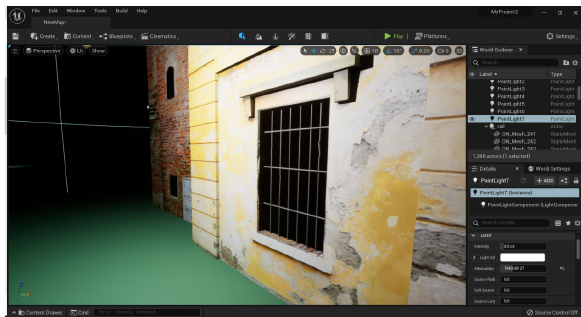
Figure 9. Final results of the mill model recreated in Unreal Engine